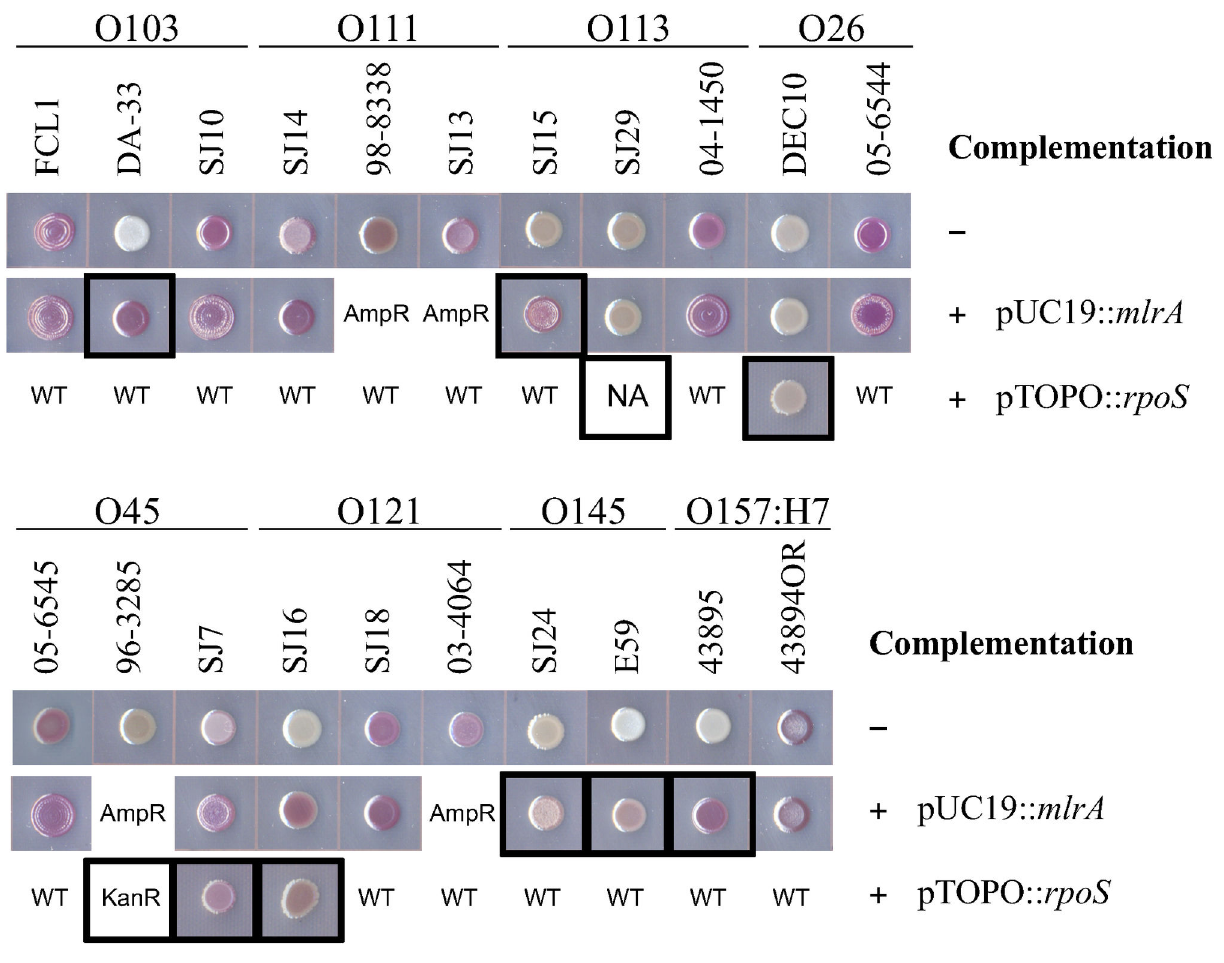
Figure 1. Congo red affinity of STEC strains with or without complementing plasmids pUC19:: mlrA or pTOPO:: rpoS . Strains carrying mutant mlrA or rpoS genes were marked with black boxes. AmpR/KanR: antibiotic resistance preventing the complementation experiments. WT: strain carries wild-type RpoS protein thus not complemented. NA: stable transformant not achievable. doi: